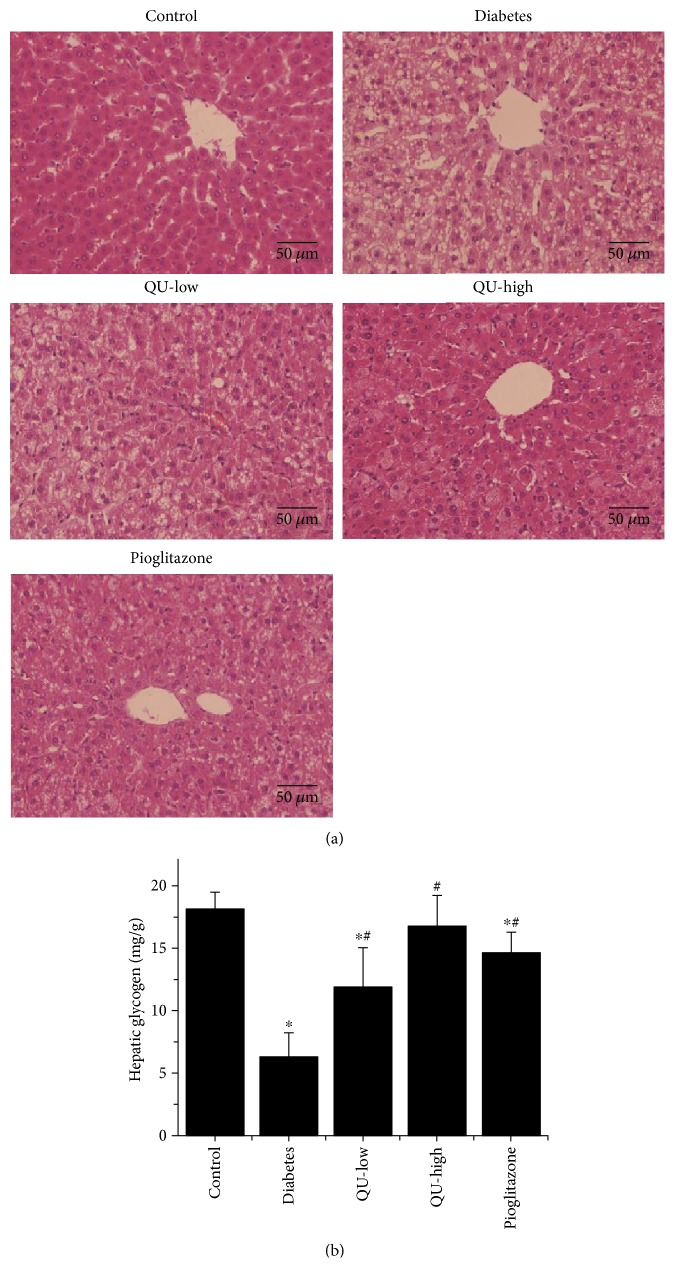
Quercetin ameliorated the hepatic histomorphological injury and enhanced hepatic glycogen content levels in STZ-induced diabetic rats. (a) Images of hepatic histopathological analysis by hematoxylin-eosin (HE) staining display representative hepatocytes and structures of the hepatic lobule of HE-stained sections in control, diabetes, QU-low, QU-high, and pioglitazone-treated rats at an original magnification of 200x. (b) Hepatic glycogen content of control, diabetes, QU-low, QU-high, and pioglitazone-treated rats was evaluated by anthrone assay. Data are means ± SD, n = 8. ∗P < 0.05 versus control group and #P < 0.05 versus diabetic group by ANOVA.